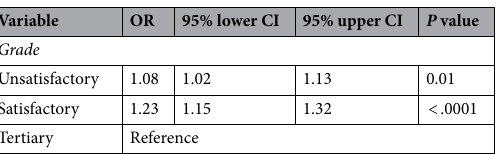
Table 4. OR and 95% confidence interval (CI) of grades to exacerbation in whole-group model (QICu = 110,830).